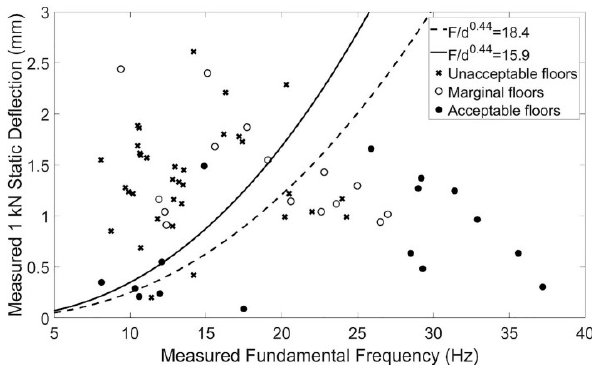
Figure 5. The new vibration criteria proposed by Zhang and Xu [40] for lightweight cold-formed steel floors versus subjective evaluation. Reproduced from [40] with permission.